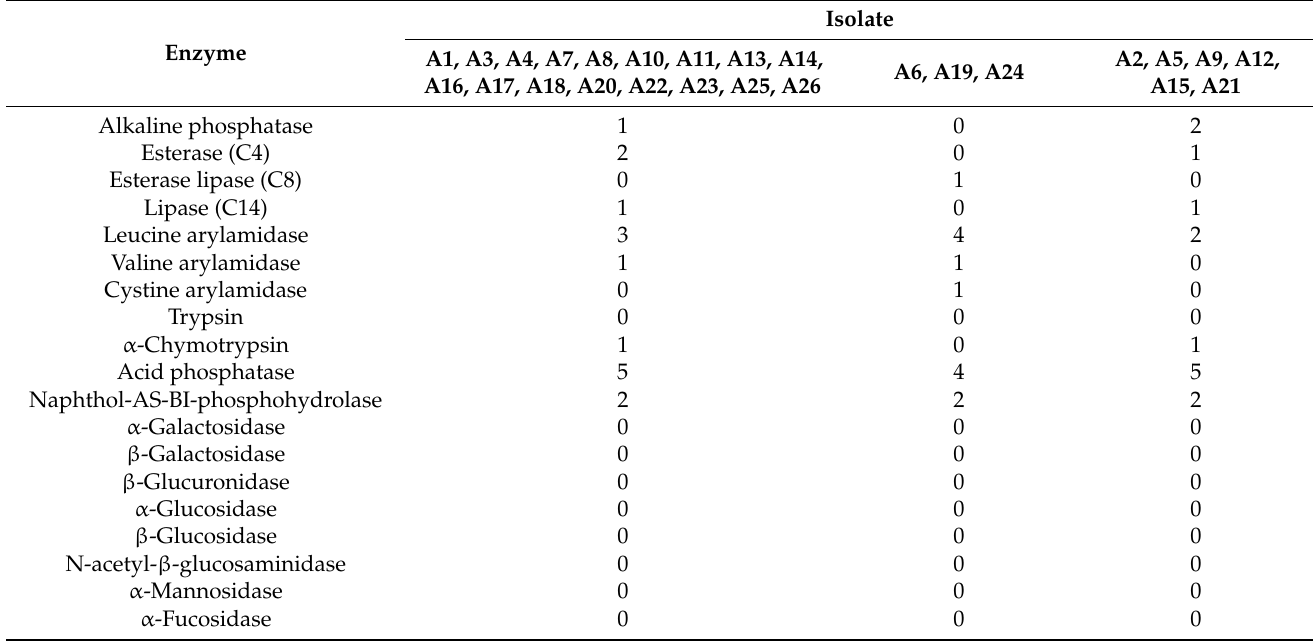
Table 3. Enzyme activities of the L. lactis strains isolated from cow milk determined by the API- ZYM